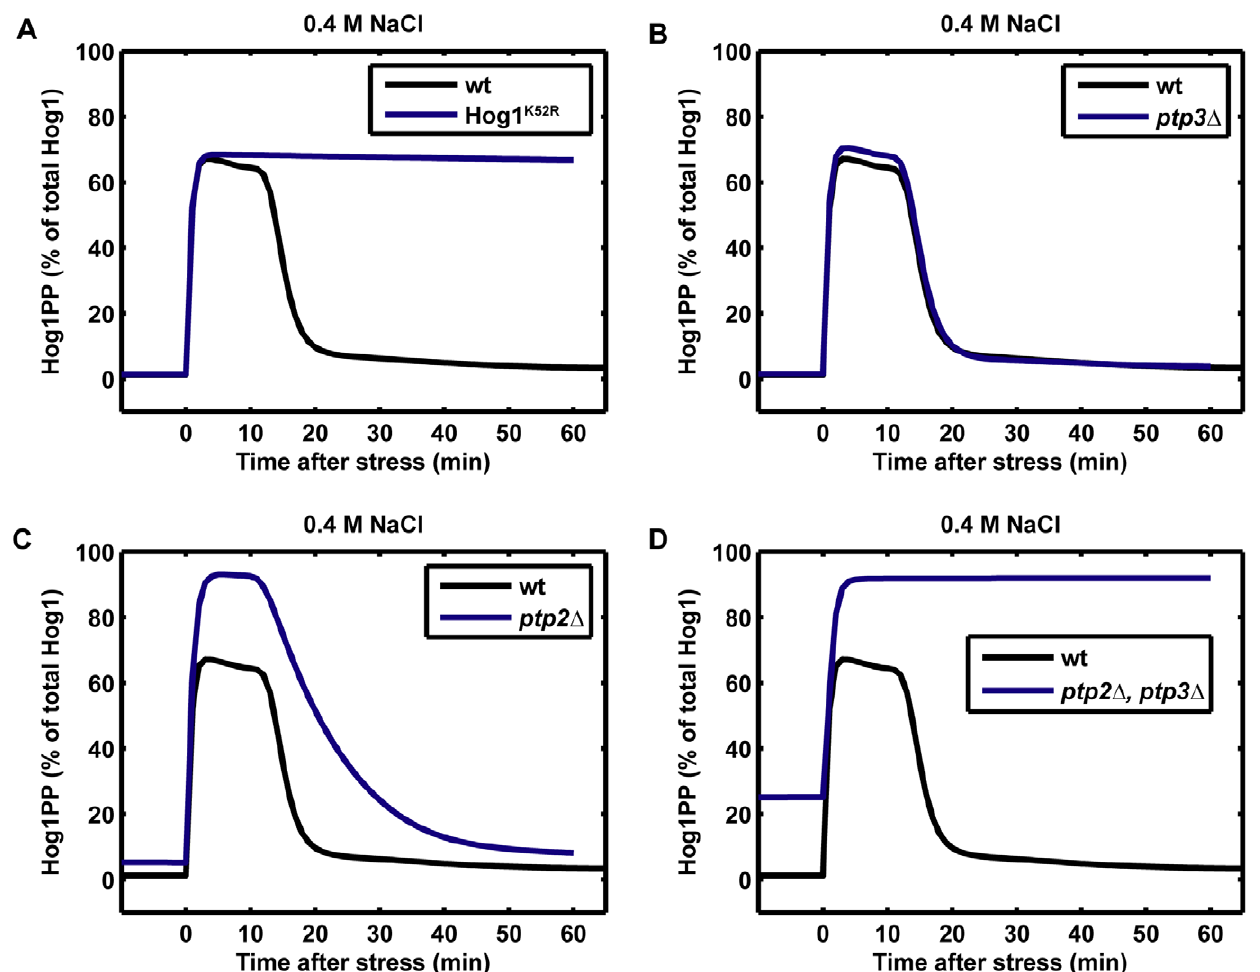
Figure 4. Model predictions for Hog1 phosphorylation response to step increase of 0.4 M NaCl in different mutants. ( A ) Hog1 catalytically inactive mutant (Hog1K52R), In the model, we set ks1_Glyc=0 for this mutant. ( B ) Knockout of cytoplasmic protein tyrosine phosphatase Ptp3 ( ptp3 D ). In the model, we set kdepho_Hog1PPc=0 for this mutant. ( C ) Knockout of nuclear protein tyrosine phosphatase Ptp2 ( ptp2 D ). In the model, we set kdepho_Hog1PPn=0 for this mutant. ( D ) Knockouts of Ptp2 and Ptp3 ( ptp2 D , ptp3 D ). In the model, we set kdepho_Hog1PPc=0 and Kdepho_Hog1PPn=0 for this mutant.